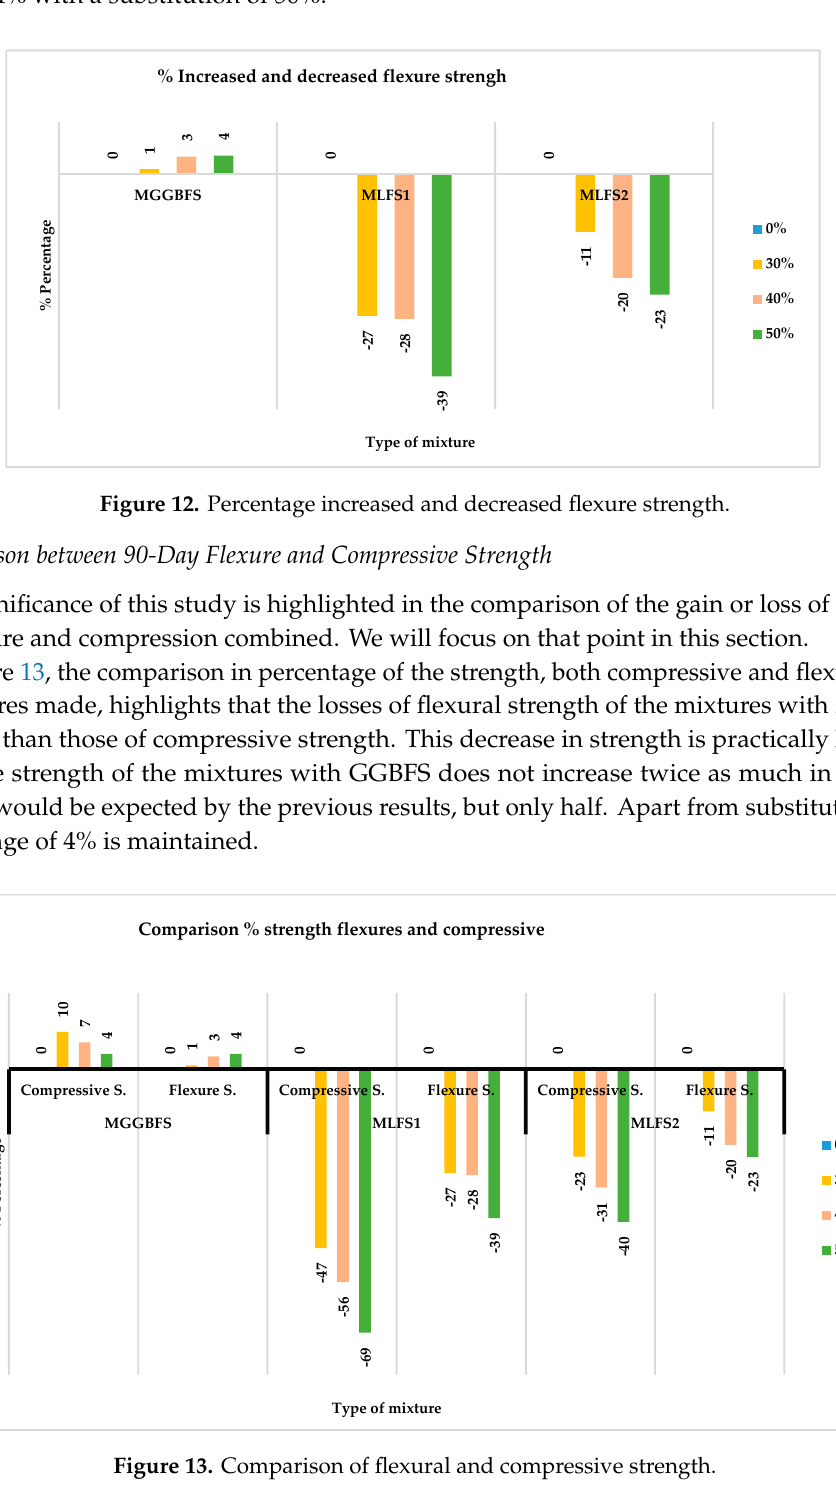
Figure 11. Flexure strength test at 90 days.